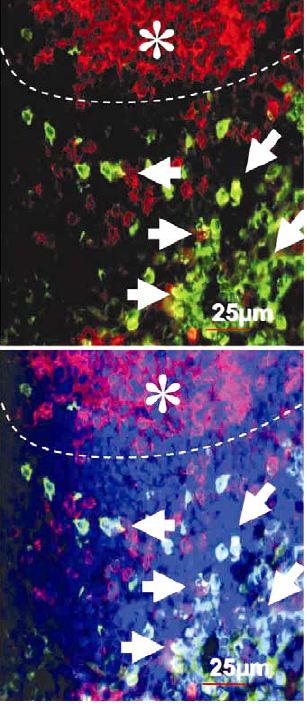
Fig. 4. Co-expression of TNF- α with TNFR-1 by an immunoflu- orescent double staining: Immunofluorescent double staining im- ages demonstrate a representative example of TNF- α expres- sion by tumor cells (asterisks) with adjacent TNFR-1 express- ing tumor infiltrating immune cells (arrows) in patients with CRC with (bottom) and without (top) nuclear counterstaining. Indica- tion line shows tumor border in adjacent to infiltrating immune cells. FITC green Fluoresceinisothiocyanat, Cy3 red, and DAPI 4 (cid:2) ,6-Diamidino-2-phenylindoldihydrochlorid blue. Calibration bar represents 25 µm. (The colors are visible in the online version of the article; http://dx.doi.org/10.3233/ACP-CLO-2010-0539.)